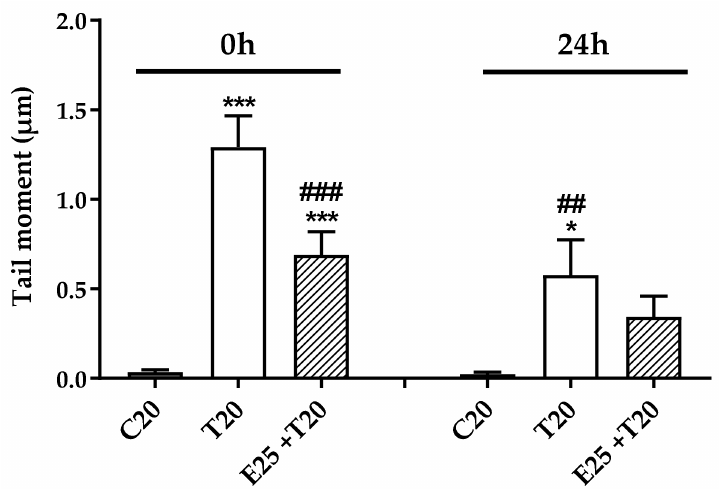
Figure 4. Comparison between Alkaline Comet assay performed after 0 and 24 h from UV-A exposure, expressed as Tail moment. HMEC-1 cells were treated for 1 h with the extract (25 µ g / mL, E25) and exposed to 20 J / cm 2 UV-A (T20). Results are expressed as mean of medians ± SEM, n = 3. Statistical analysis: One-Way ANOVA with Bonferroni’s post hoc analysis.* p < 0.05, *** p < 0.001 vs. C20, ## p < 0.01 ### p < 0.001 vs. T20